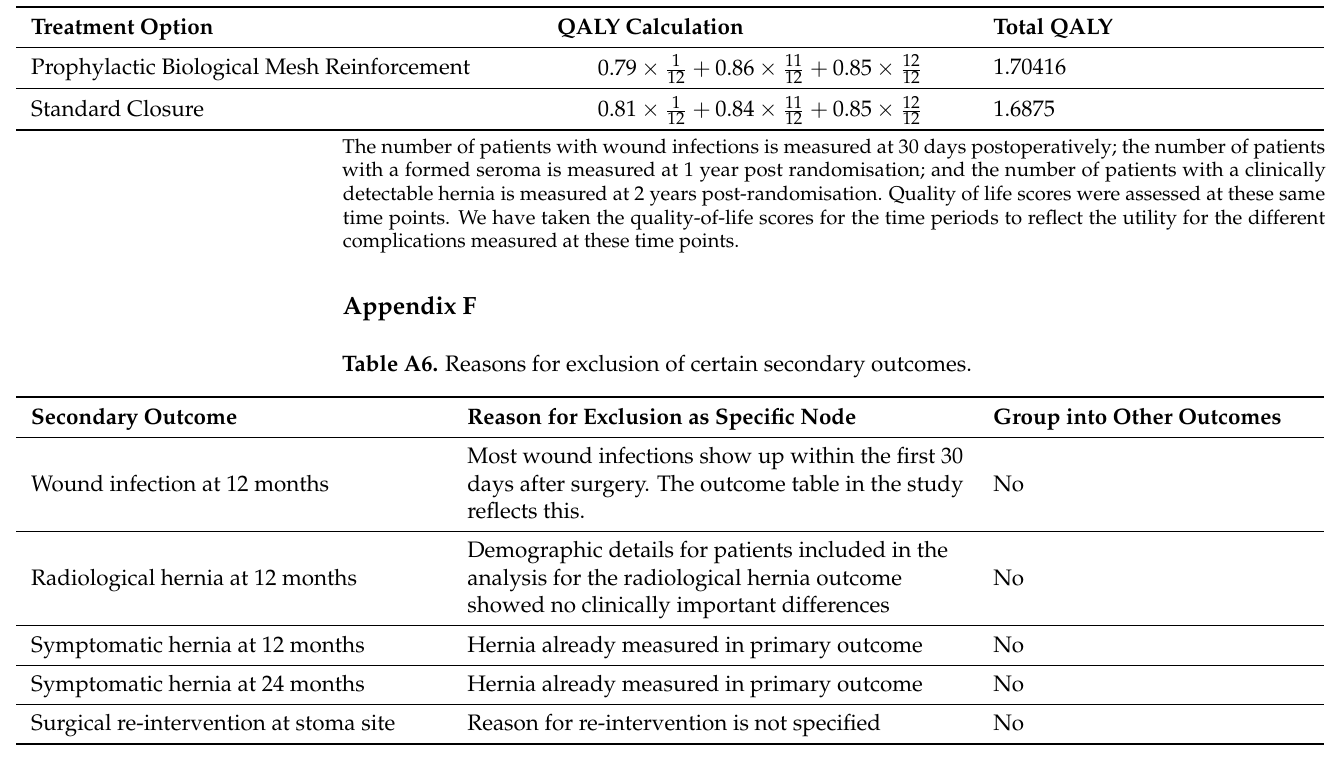
Table A5. Calculations conducted to obtain the expected QALY at each decision node in the tree.